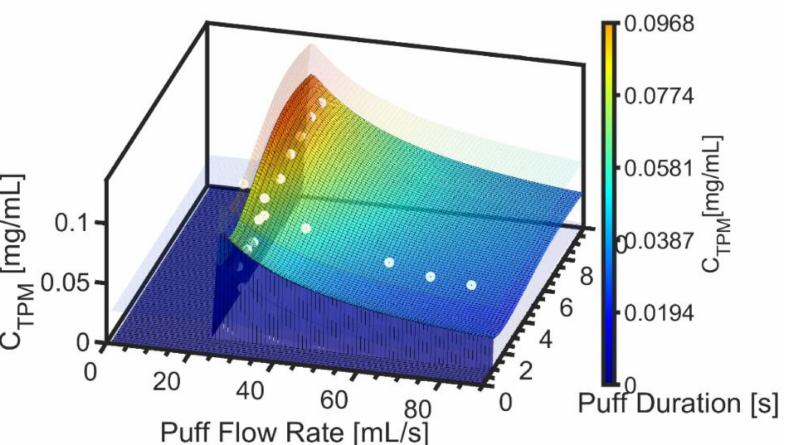
Figure 4. Product EC14-01. Screening emissions model for TPM mass concentration is illustrated as the colored surface plot, with semitransparent surfaces above and below the model surface to reflect the 95% confidence interval on the nonlinear regression. Underlying data are illustrated with